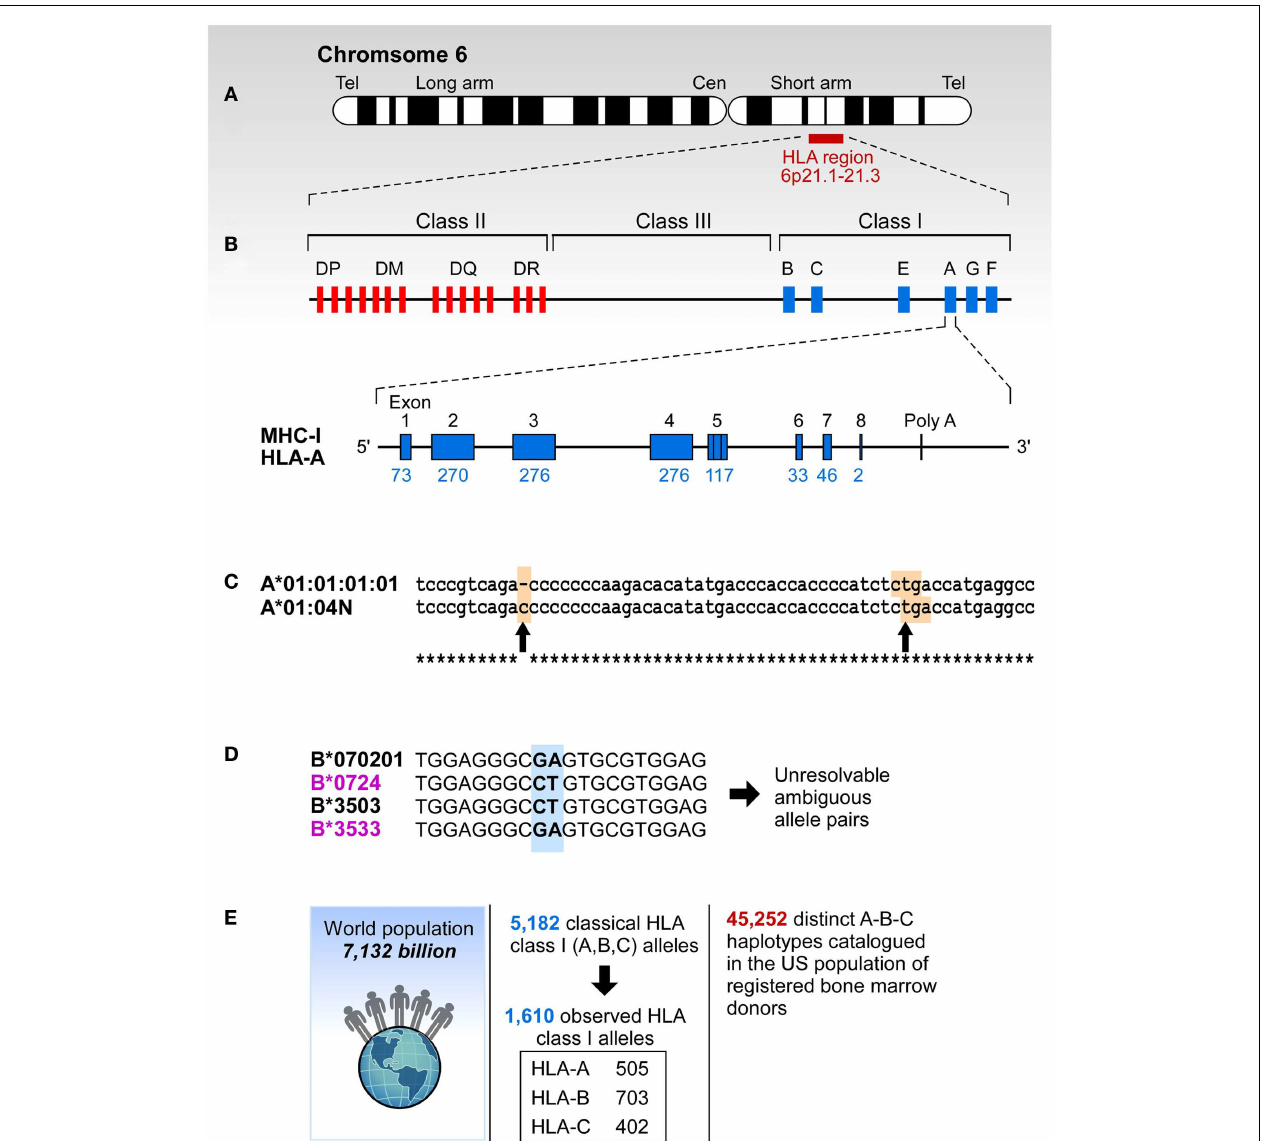
case both B*07:02/B*35:03 and B*07:24/B*35:33 are possible. However, B*07:24 and B*35:33 alleles are rare, they have been observed in